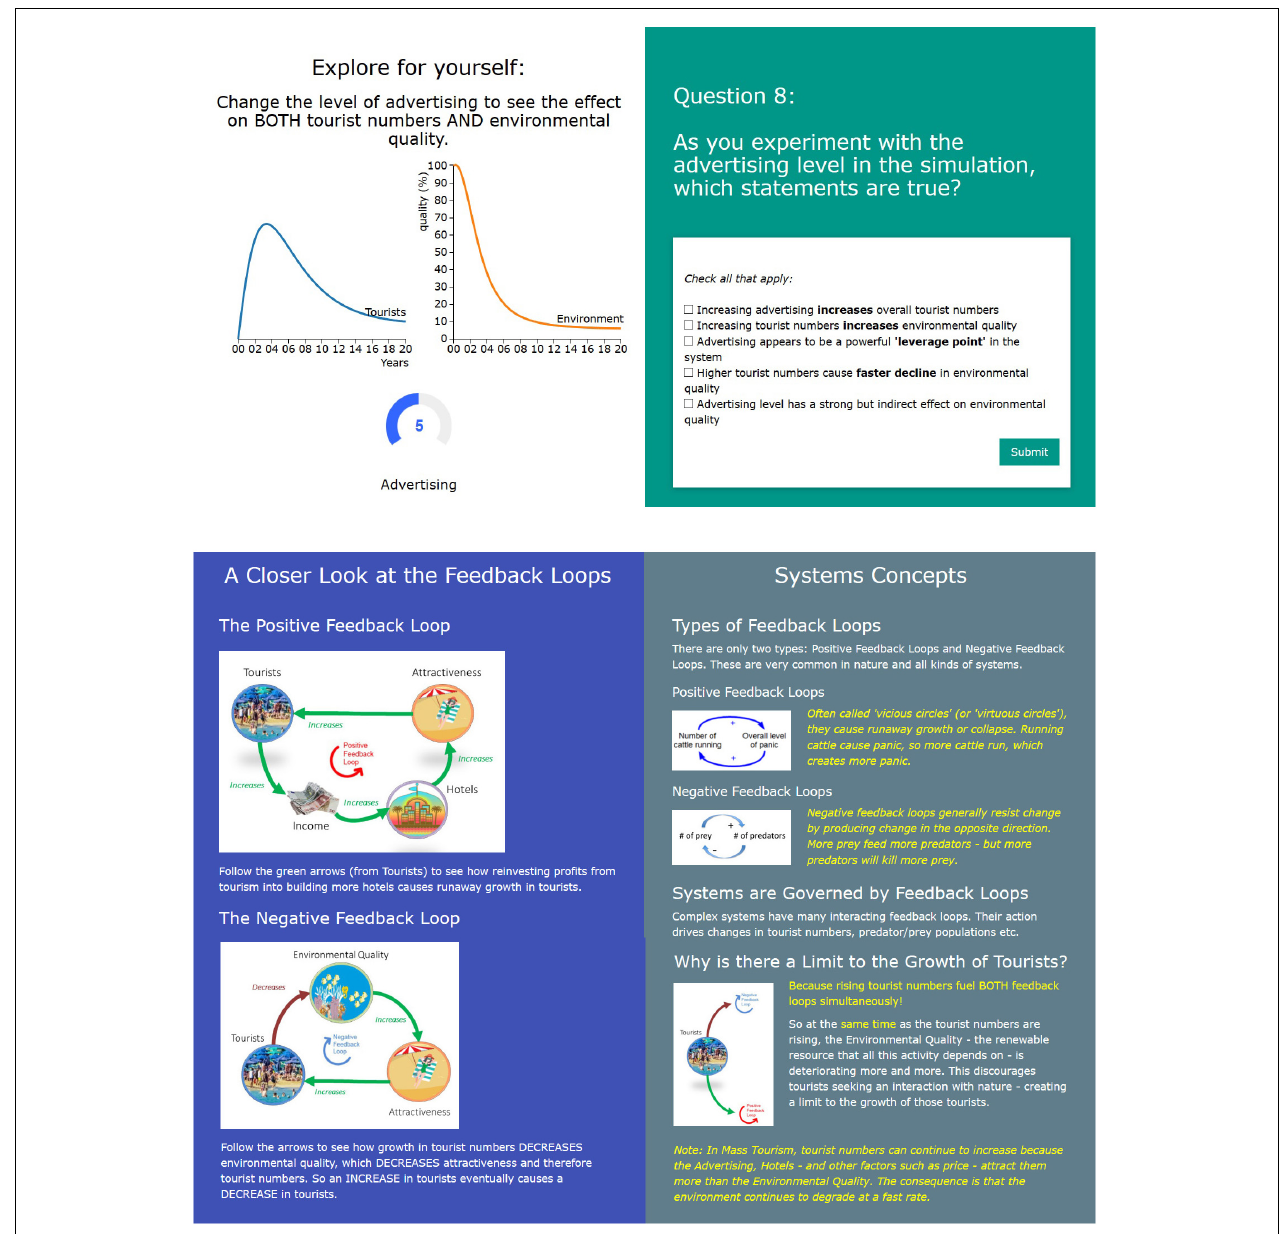
FIGURE 3 | OL tool screenshots: simulation showing two key stocks and a key variable, together with a reinforcing in-tool quiz question; feedback loops explained using Causal Loop diagrams, both in the context of Coastal Tourism, and in general System Thinking terms (RQ1).